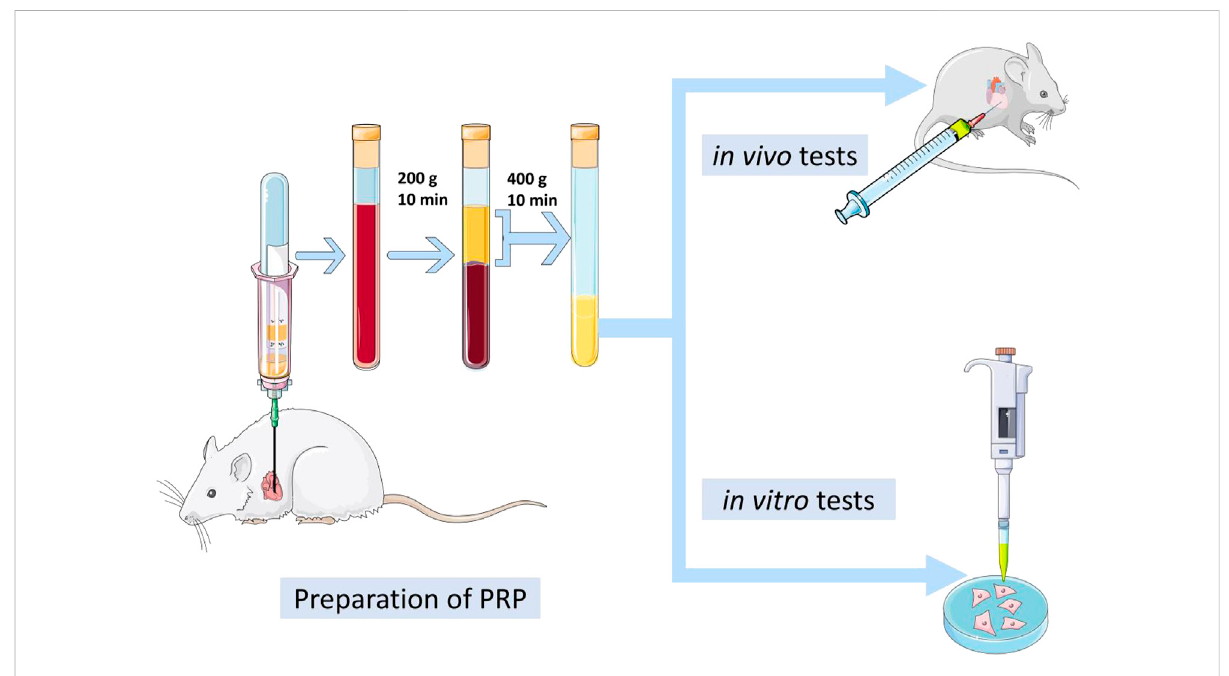
The fl ow diagram for the experimental procedures.